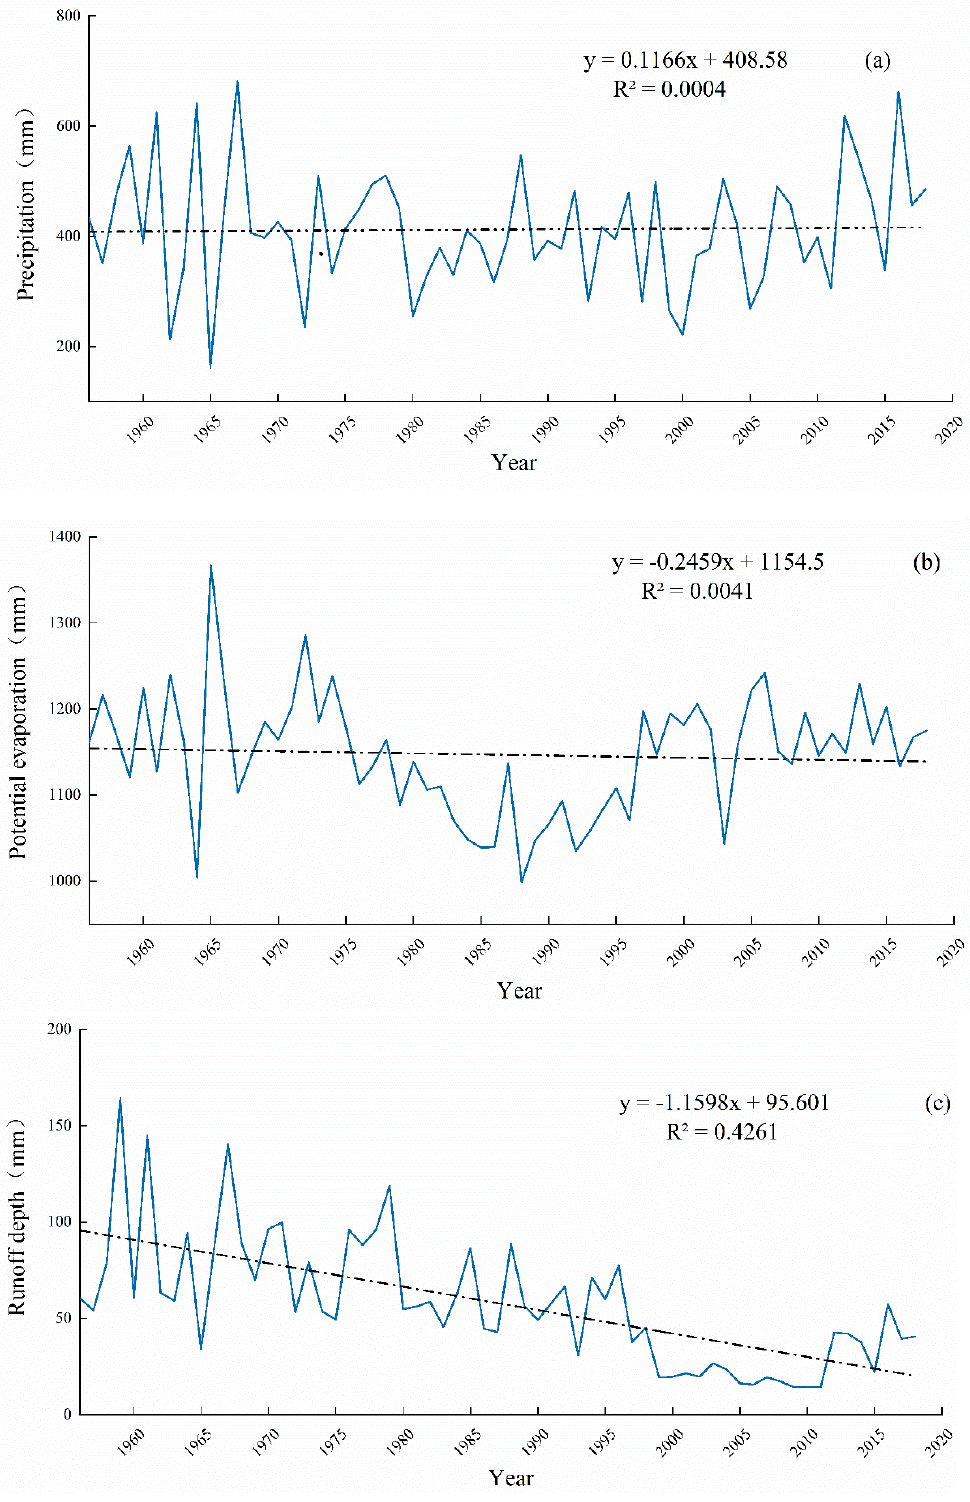
Figure 2. Mann–Kendall (MK) trend test of the ( a ) annual precipitation, ( b ) potential evapotranspiration, ( c ) runoff depth. UF, UB, and p are the statistics in the Mann–Kendall trend test, respectively.